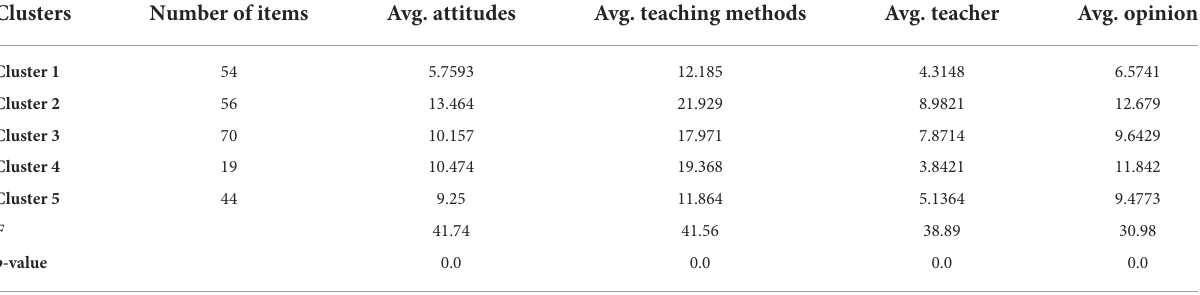
TABLE 2 Average score of dimension in each cluster.